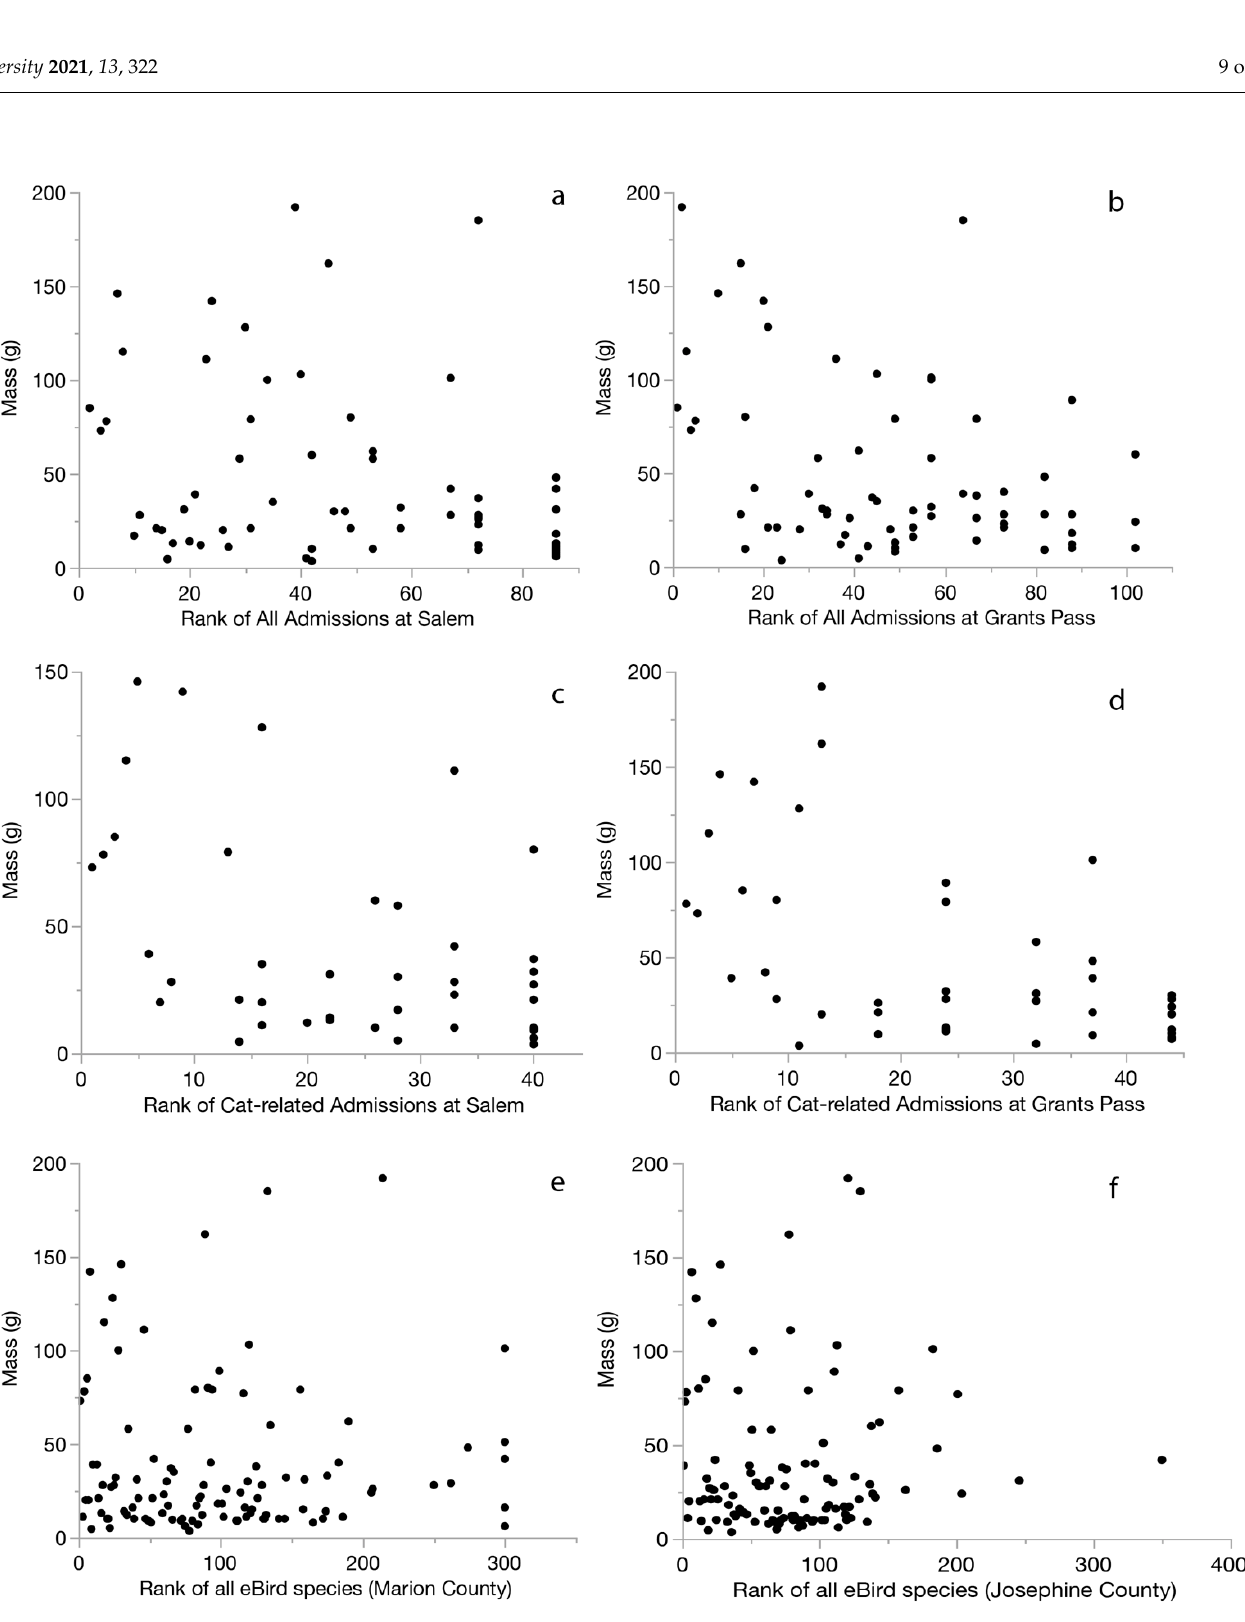
Figure 2. Species with a mean adult mass of less than 70 g were much less likely than larger species to be admitted for any reason to a wildlife rehabilitation center in Salem ( a ) and Grant Pass ( b ). This was also true for birds admitted after interacting with a cat in Salem ( c ) and Grants Pass ( d ). Local abundances, based on eBird checklists, did not show the same pattern in either Marion County ( e ) or Josephine County ( f ).